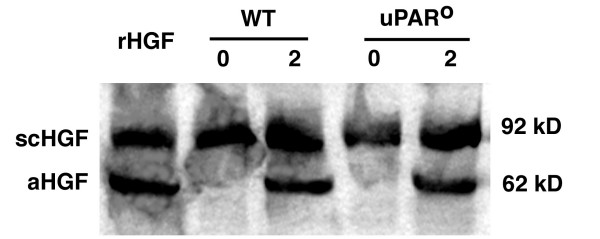
Normal activation of cell-associated hepatocyte growth factor in uPAR° livers during liver repair. Western analysis of hepatocyte growth factor (HGF) partially purified from the soluble fraction of liver extracts using an antibody that recognizes the single chain and heavy chain (to demonstrate activation) of HGF shows similar levels of activation in WT and uPAR° livers at baseline (day 0) or at 2 days after CCl4 administration. scHGF = single chain HGF; aHGF = activated HGF, rHGF = recombinant HGF.